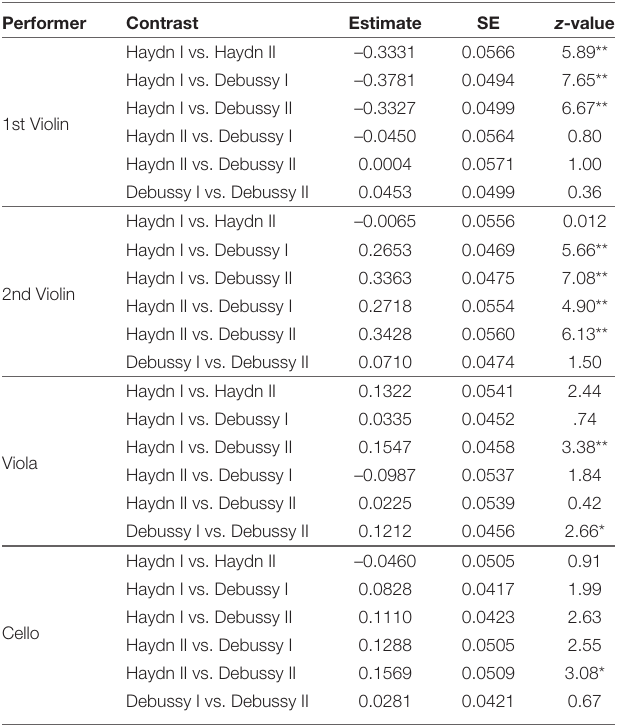
TABLE 4 | Results of the LMMs testing within-performer/between-piece differences in pupil diameter. Performer Contrast